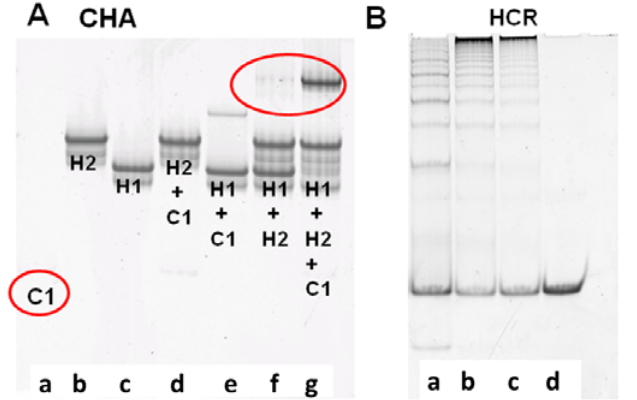
Figure 1. Verification of CHA and HCR products. ( A ) 15% PAGE gel after 3-hour CHA reaction. Concentrations of C1, H1, and H2 (in a to g) are 10 nM, 200 nM, and 400 nM, respectively; ( B ) 8% PAGE gel after overnight HCR reaction. Concentrations of H3 and H4 are both 200 nM. Concentrations of the initiator mimic (InM) from a to d are 100 nM, 50 nM, 25 nM, and 0